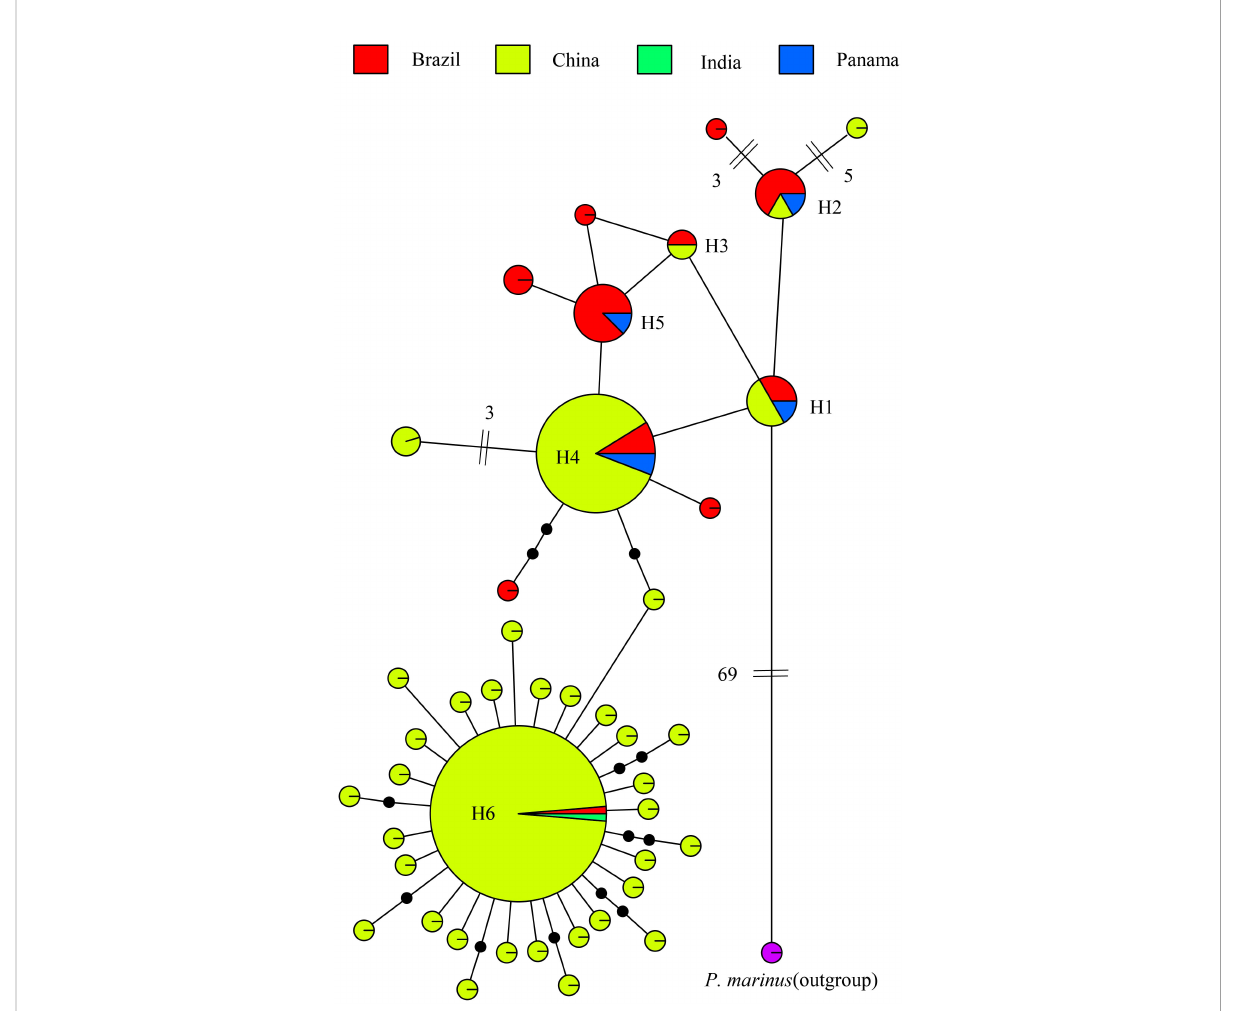
FIGURE 4 Haplotype networks of Perkinsus beihaiensis based on internal transcriber spacer sequence from China (this study) and additional sequences from GenBank that contained the sample location in their records. Colors indicate countries sampled. Neighboring haplotypes without double cross-bars indicate a single nucleotide mutation step or a gap. A nucleotide mutation step or gap of >1 between neighboring haplotypes is marked with double cross-bars, and the total numbers are indicated beside it. Black circles indicate inferred haplotypes not found in the sampled populations. Shared haplotypes are marked from H1 to H6 beside or inside the pie charts. The areas of the circles are proportional to the number of samples of each haplotype. Perkinsus marinus was used as the